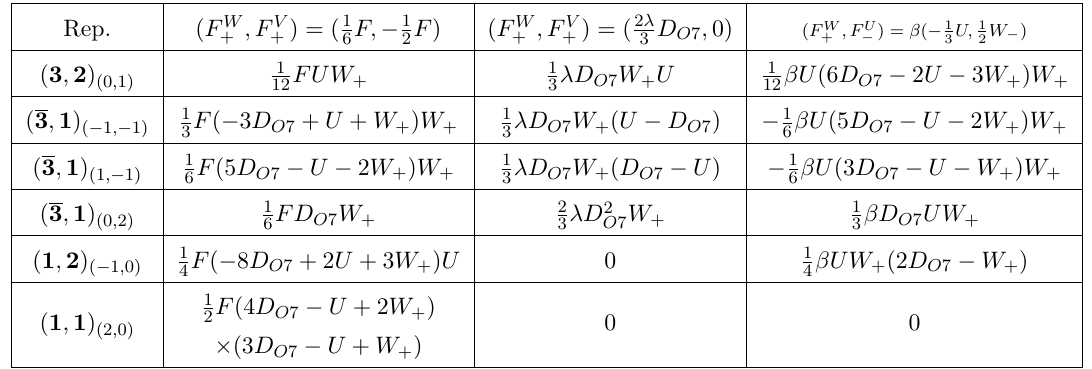
Table 3 . Chiralities in the perturbative limit for the allowed D5-tadpole canceling (cid:13)uxes. In the central column we used the identity (3.38)